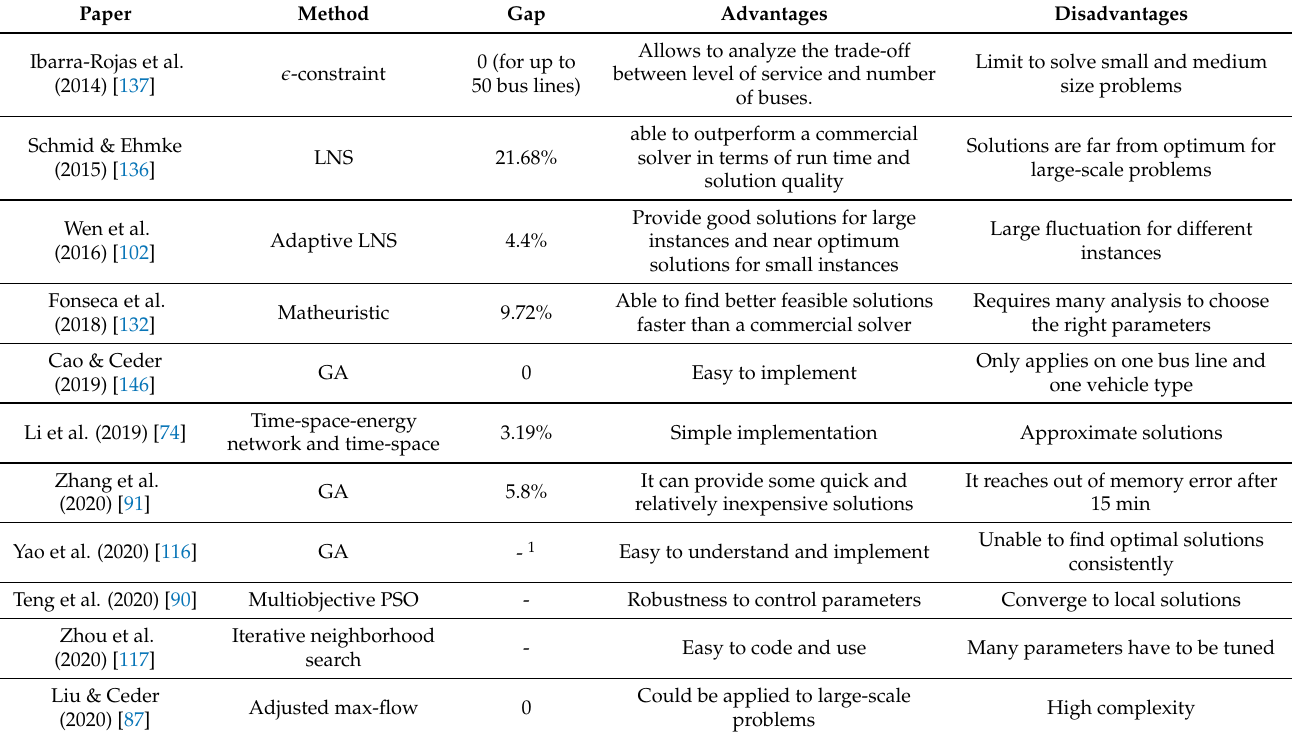
Table 8. Comparison of the different studies in terms of accuracy and solution